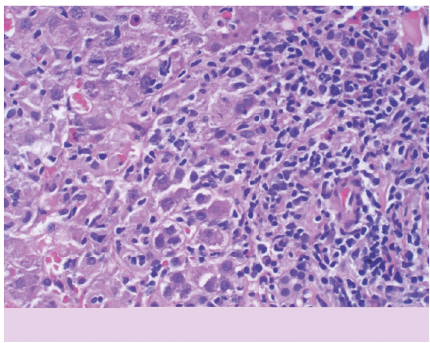
Figure 2: Hepatocytes at the interface are surrounded by inflamma- tory cells, causing hepatocellular damage (40x